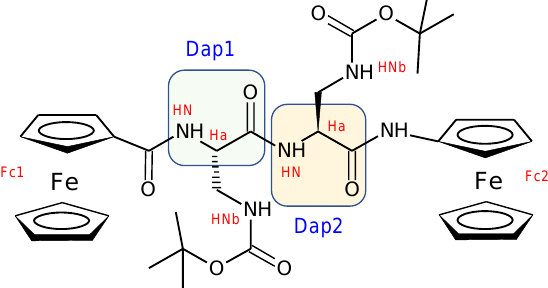
Scheme 1. Functional groups of 2 with labels.